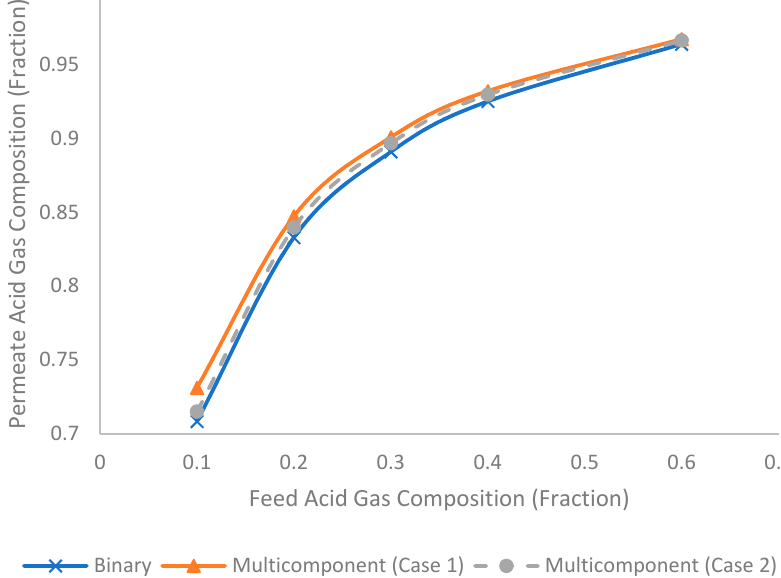
Figure 16. Evolution of permeate acid gas composition (fraction) under different feed acid gas composition (fraction) for binary and multicomponent systems.